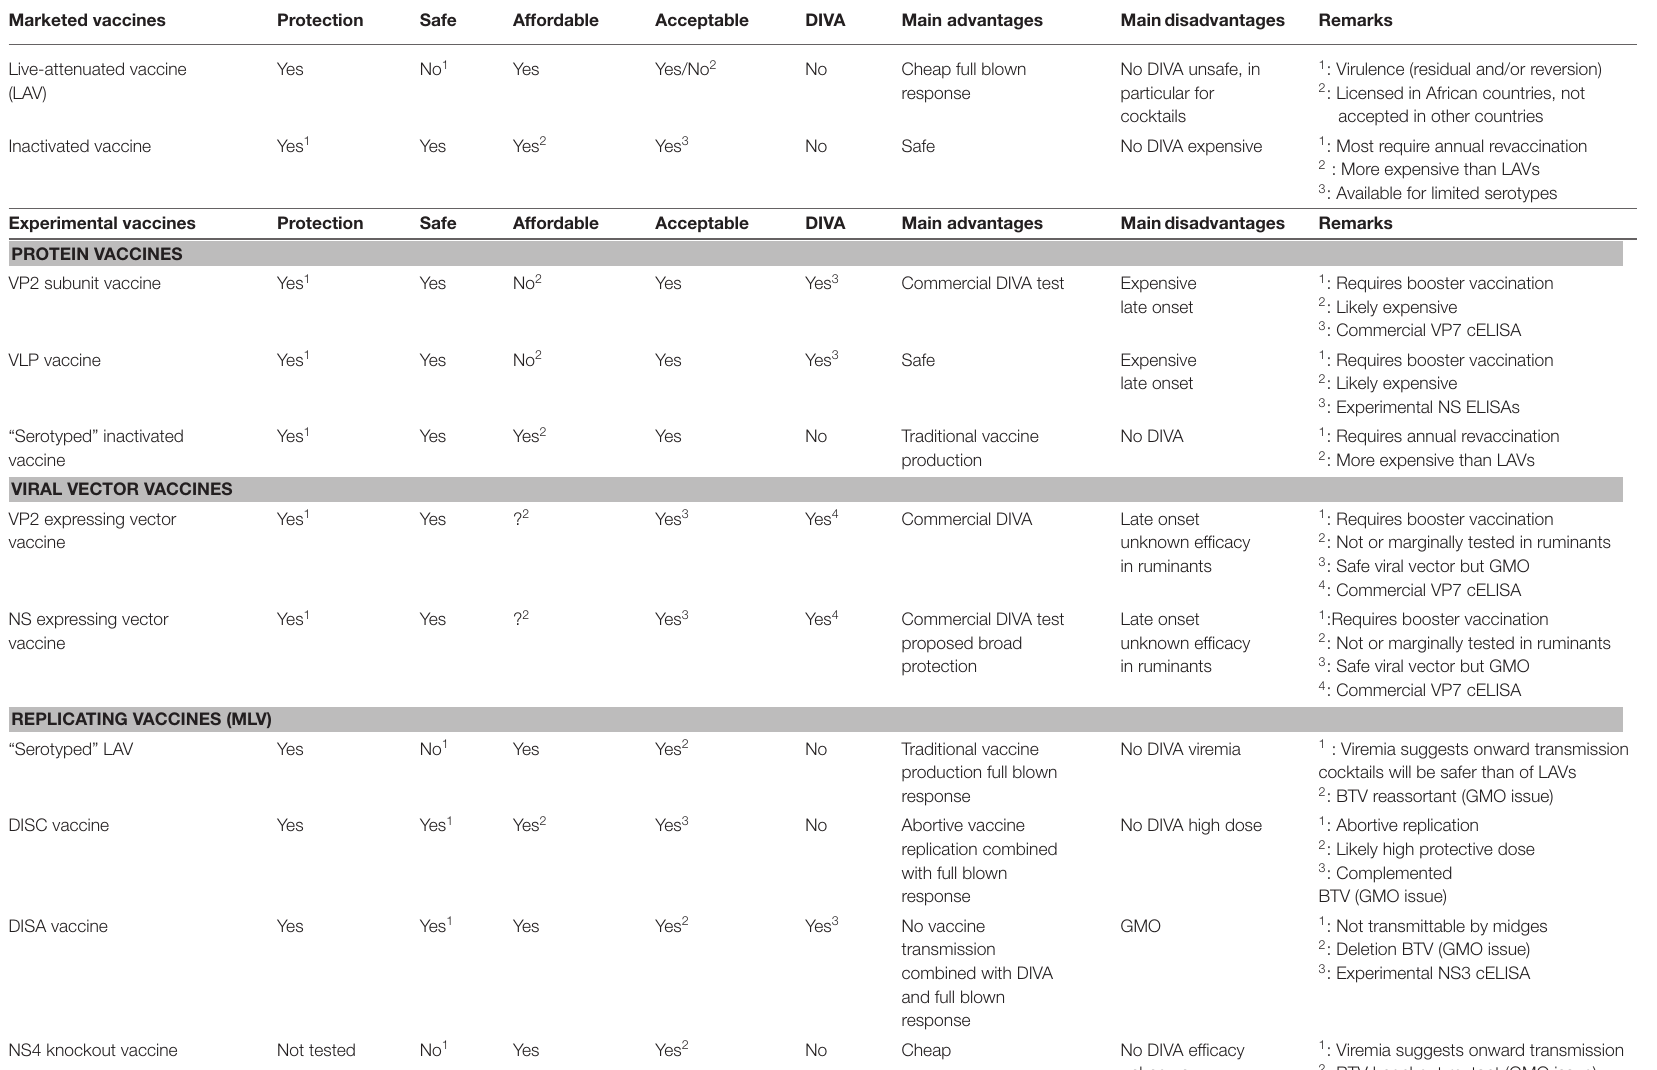
TABLE 1 | Evaluation of vaccine profiles of marketed and experimental